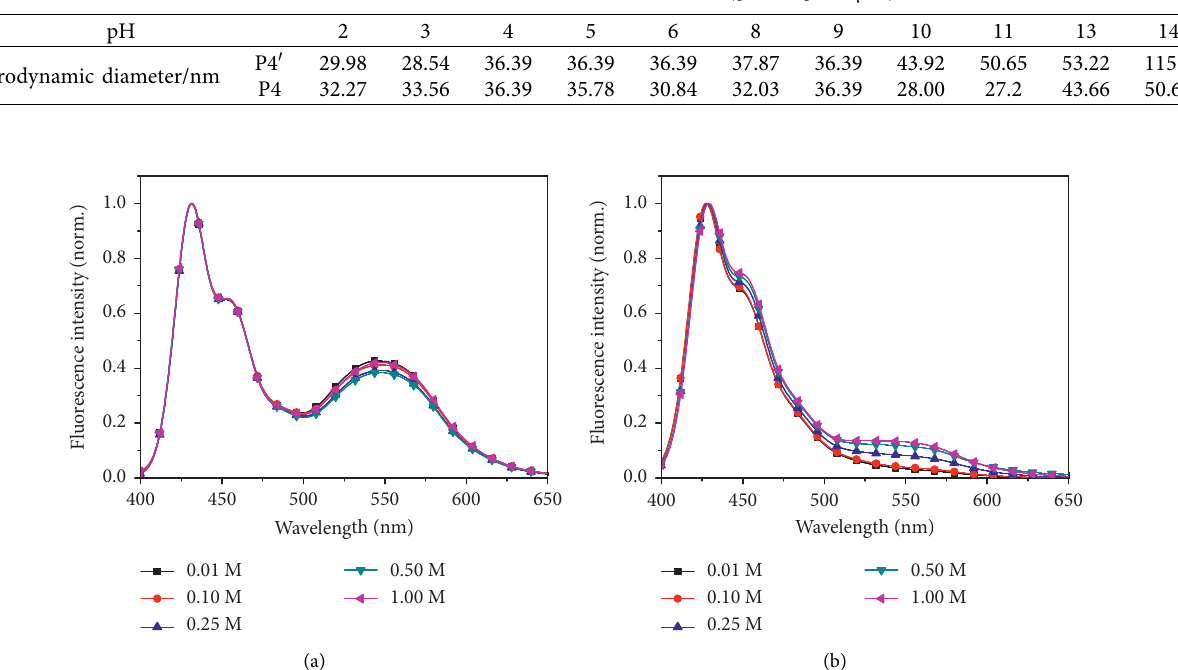
Figure 9: PL of P4 (a) and P4 ′ (b) in the presence of a series of concentrations of NaCl (excitation at 384